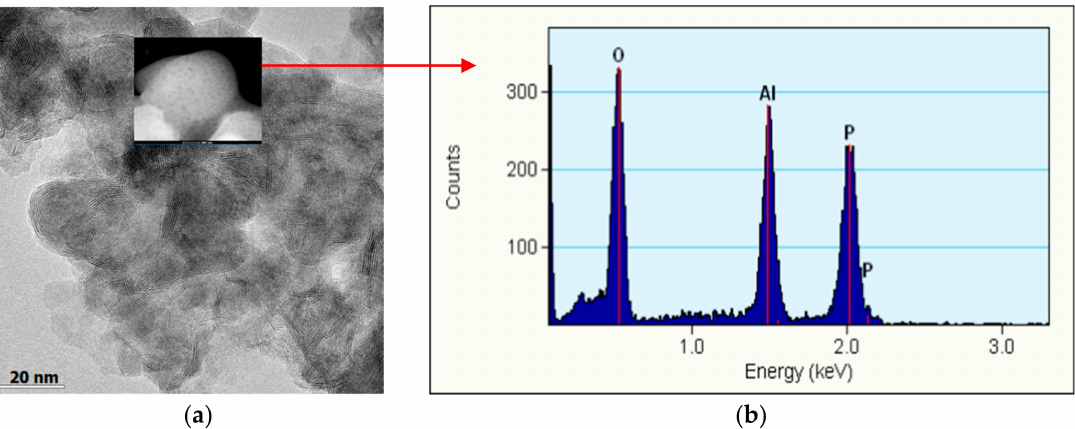
Figure 8. TEM analysis on the spent catalyst representing ( a ) BF-TEM micrograph, inset in ( a ) shows a characteristic area of the support and ( b ) energy dispersive X-ray (EDX) analysis on the characteristic area in ( a